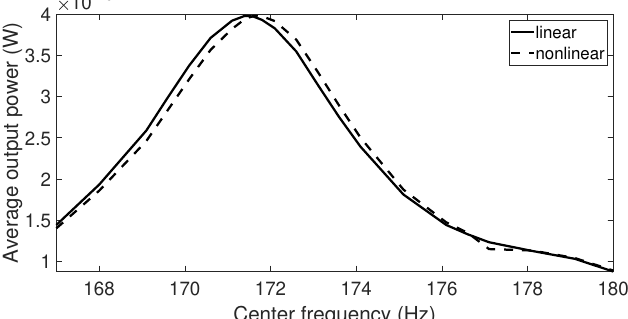
Figure 12. The average output power response for the linear and nonlinear prototypes under car-in-highway excitation when the center frequency of the excitation is swept.